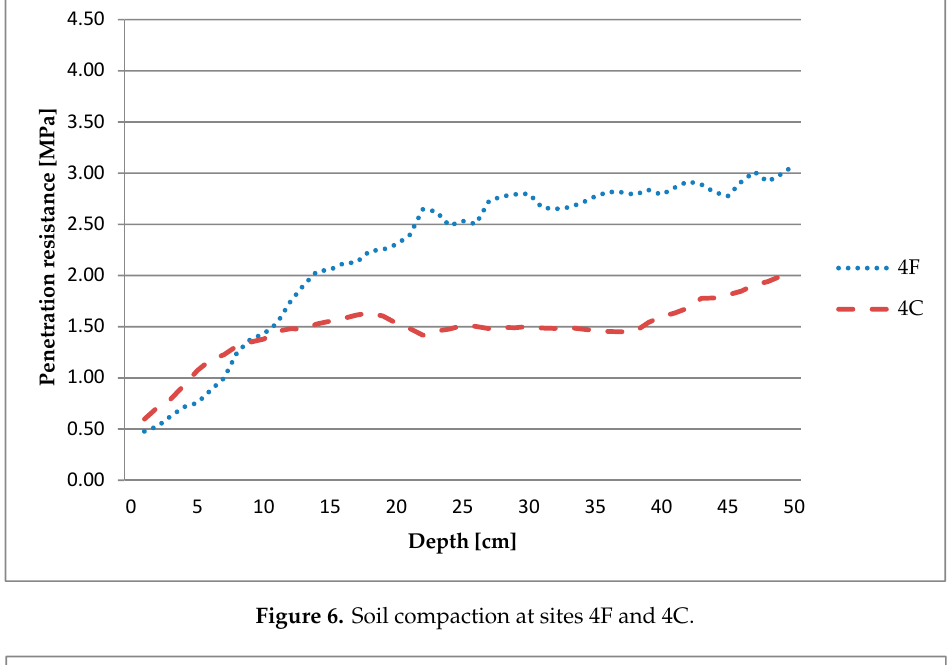
Figure 5. Soil compaction at sites 3F and 3C.